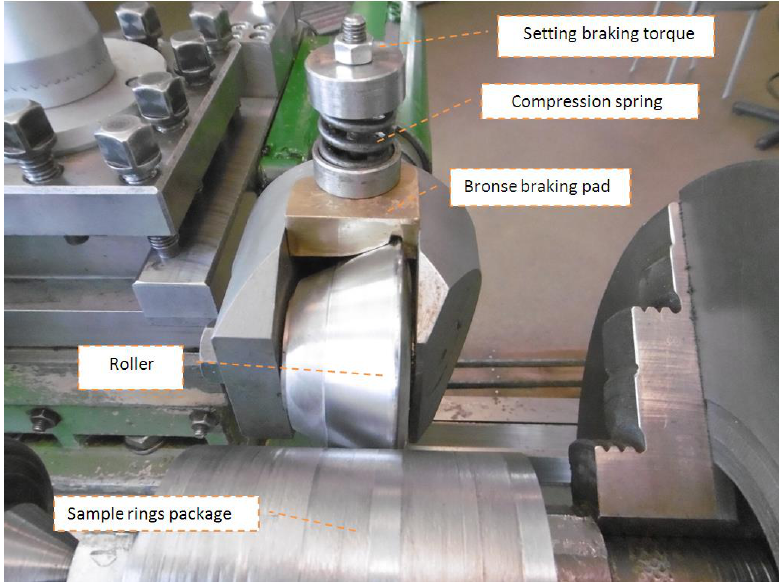
Figure 7. Burnishing device with mounted roller brake.